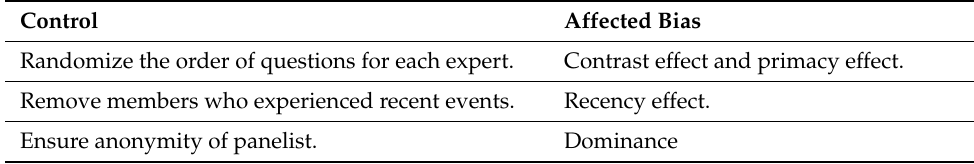
Table 5. Control for bias in our staticized groups